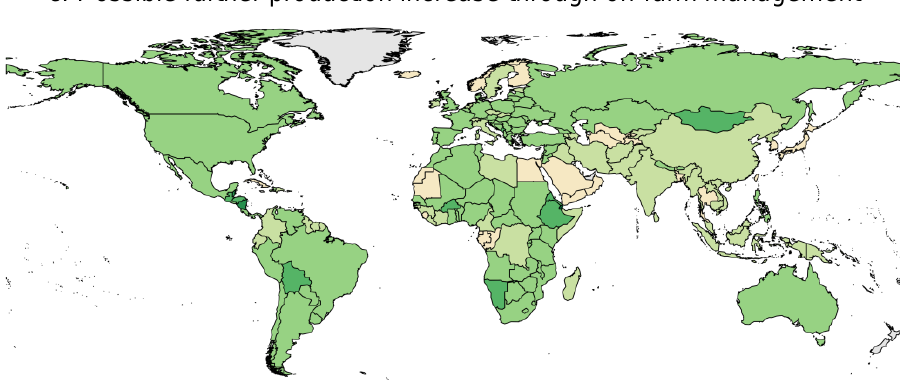
Fig. 2. (a) LPJmL-computed country average NPP water limitation during the growing season on current cropland (1971–2000), expressed in terms of the water limitation index also used in Fig. 1. (b) Increase in crop production currently achieved through irrigation (assuming that irrigation demand can always be met on areas currently equipped for irrigation). (c) Potential further increase in rainfed and irrigated crop production through both collection of 25% of runoff from cropland and avoidance of 25% of soil evaporation. For calculation procedure and more detailed maps see Rost et al.